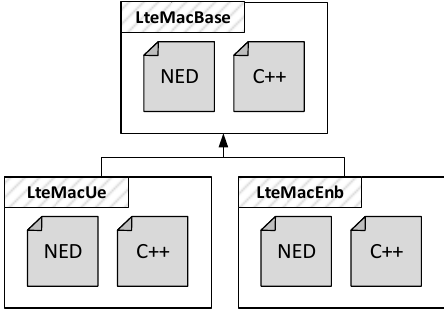
Figure 4. LTE NIC module architecture. Sensors 2018 , 18 , x FOR PEER REVIEW